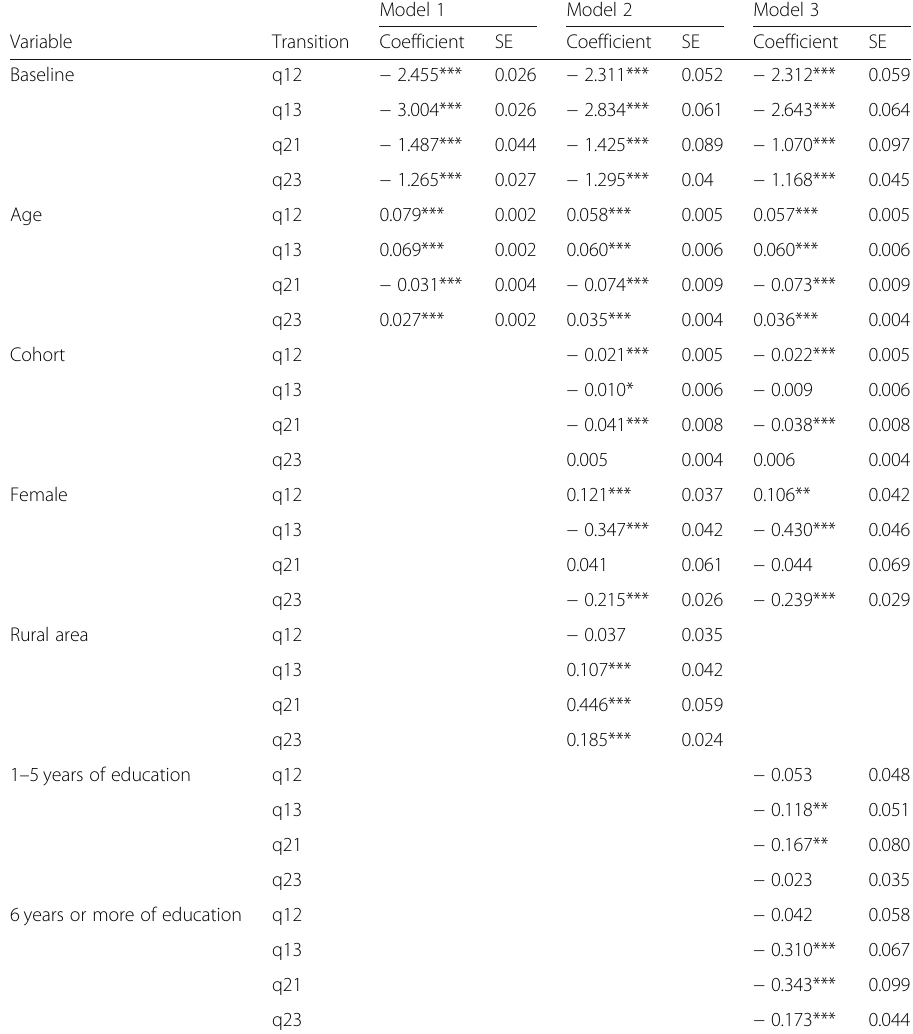
Table 3 Estimates of transitional intensities of the multi-state